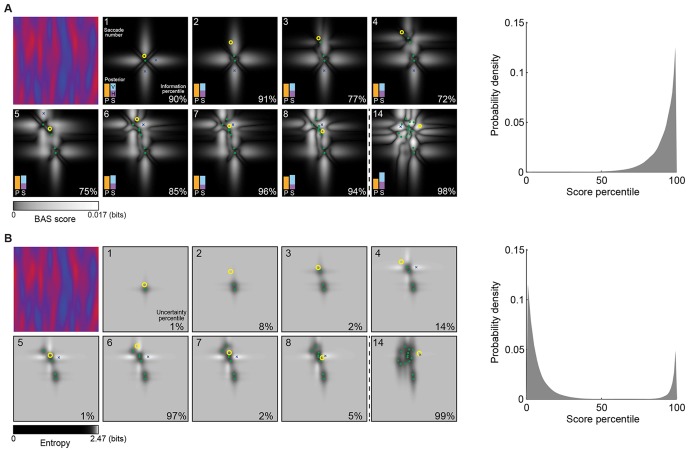
Example trial of the Bayesian active sensor (BAS) and its maximum entropy variant.(A) The operation of BAS in a representative trial for saccades 1–8 and 14 (underlying image shown top left). For each fixation (left, panels), BAS computes a score across the image (gray scale, Equation 1). This indicates the expected informativeness of each putative fixation location based on its current belief about the image type, expressed as a posterior distribution (inset, lower left), which in turn is updated at each fixation by incorporating the new observation of the pixel value at that fixated location. Crosses show the fixation locations with maximal score for each saccade, green dots show past fixation locations chosen by the participant and yellow circle shows current fixation location. Percentage values (bottom right) show their information percentile values (the percentage of putative fixation locations with lower BAS scores than the one chosen by the participant). Histogram on the right shows distribution of percentile values across all participants, trials and fixations. (B) Predictions of the maximum entropy variant (the first term in Equation 1) as in (A). For saccades 1–3, the fixation locations with maximal score (crosses) are not shown because the maxima comprise a continuous region near the edge of the image instead of discrete points. Note that entropy can be maximal further (eg. fixation 4) or nearer the edges of the image (eg. fixation 1), depending on the tradeoff between the two additive components defining it: the BAS score, which tends to be higher near revealing locations (panel A), and uncertainty due to the stochasticity of the stimulus and perception noise, which tends to be greater away from revealing locations. Figure 4—figure supplement 1 shows two illustrative examples for this trade-off.